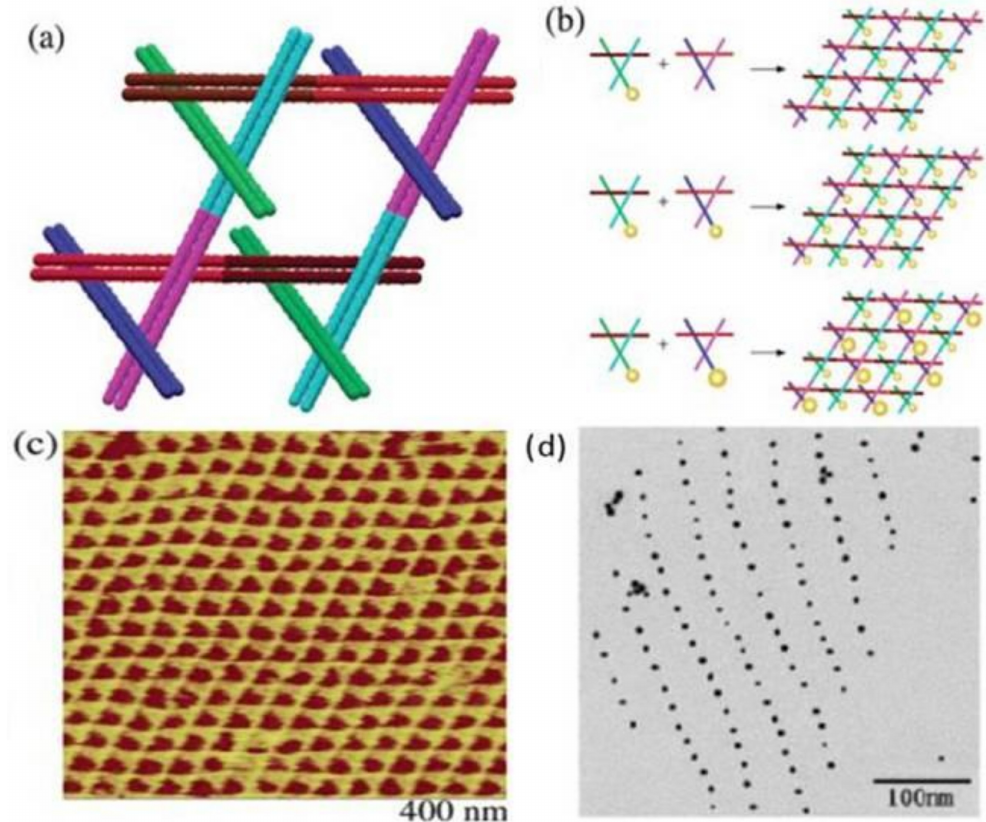
Figure 39. ( a ) The Au NPs can be shaped in a standard array of Au-nPs in a dx DNA template as shown by DX DNA triangles with sticky extremities, to allow the tiling of triangles; ( b ) Non-all ends of DNA are needed for tile purpose and the free ends could be attached to Au NP’s (yellow) 5 or 10 nm diameter; ( c ) The AFM imagery on a dx-array without the adding Au demonstrate its ordinary structure. This picture only displays au-NPs. ( a – d ) with reference authorization, ACS, Copyright 2006